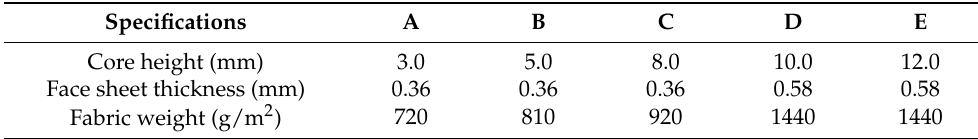
Table 1. 3D integrated woven spacer fabric specifications.